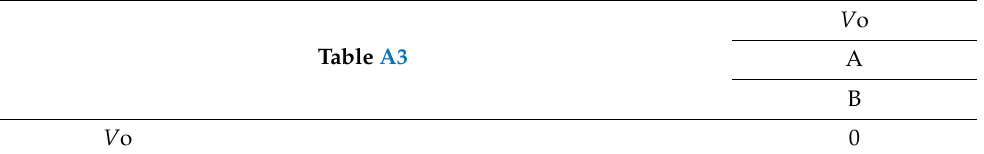
Table A6. Configurational Matrix (mutual interatomic distances in NN, as in Table A2) for x = 0.125, δ = 0.0625. Five configurations (A,B), as in Table A10.